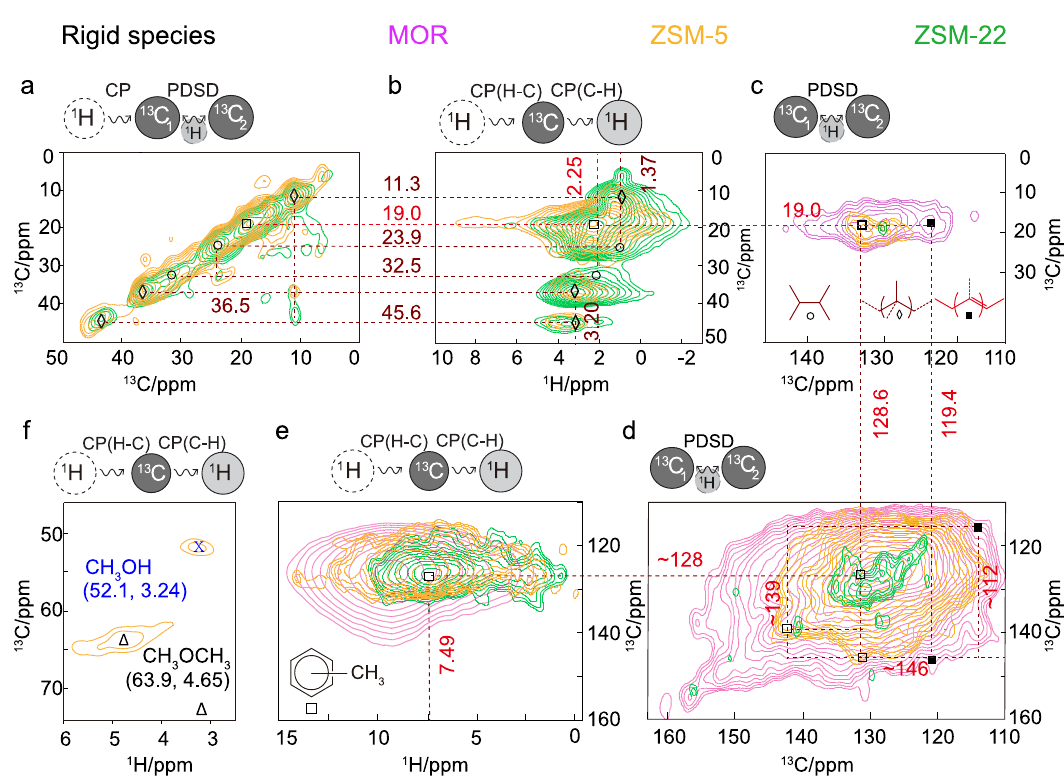
Fig. 5 Identi fi cation of postreacted zeolite-trapped rigid molecules by 2D MAS solid-state NMR spectra. a 13 C- 13 C and b 13 C- 1 H correlations in the aliphatic regions on postreacted zeolites ZSM-5 and ZSM-22. The identi fi cation of methylated aromatic/ole fi nic species via c and d 13 C- 13 C and e 13 C- 1 H correlations on zeolites ZSM-5, ZSM-22, and MOR. f 13 C- 1 H correlations highlighting methoxy region only, con fi rming the presence of methanol/DME. Identi fi ed molecular scaffolds were represented in symbols (MAS magic angle spinning). Herein, for the 13 C- 1 H correlation spectra (in b , e , and f ) “ through- space ” dipolar cross polarization was used to polarize the carbons, whereas in the 13 C- 13 C correlation spectra, the carbons were polarized either through cross polarization (in a ) or direct excitation (in c and d ) and 13 C- 13 C mixing was achieved through proton-driven spin diffusion. Spectra of trapped products obtained on respective postreacted zeolites after the hydrogenation of fully isotope-enriched 13 CO 2 in the reactant feed ( 13 CO 2 at 30 bar, 375 °C, H 2 / = 3, and 10,000mL · g − 1 · h − 1 at a time on stream of 48 h). Respective full-range spectra and experimental details are included in Supplementary 13 CO 2